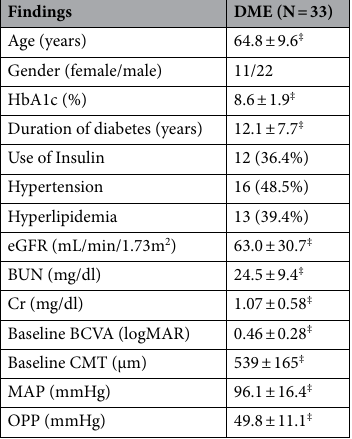
Table 1. Clinical and demographic data of the DME patients. DME = diabetic macular edema; BCVA = best- corrected visual acuity; log MAR = logarithm of the. minimum angle of resolution; CMT = central macular thickness; MAP = mean arterial pressure; OPP = ocular perfusion pressure; ‡ Mean ± standard deviation